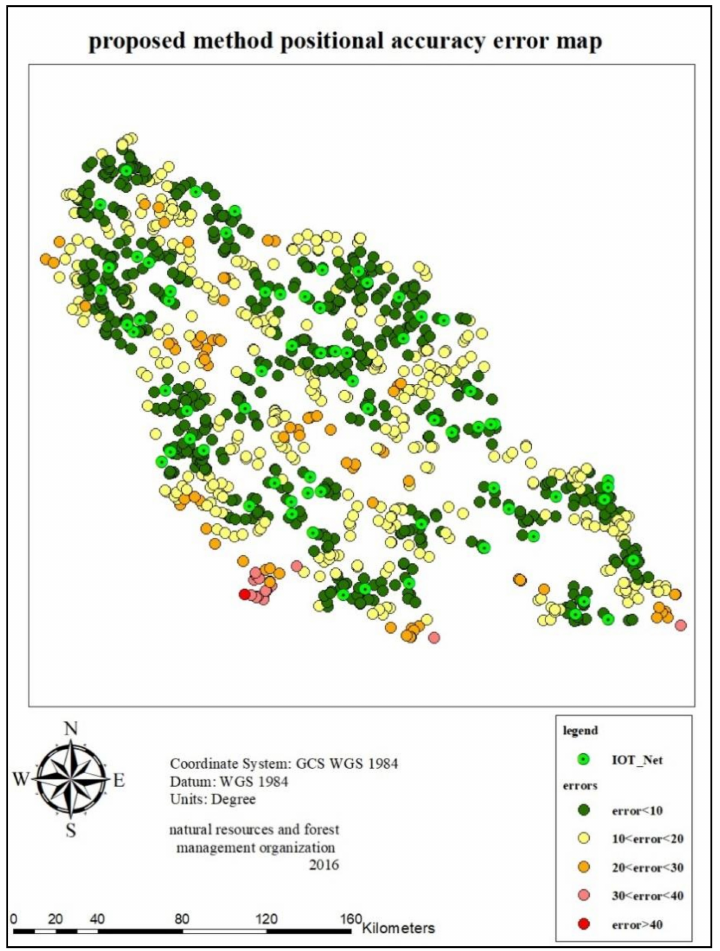
Figure 10. Positional error map of the proposed method.